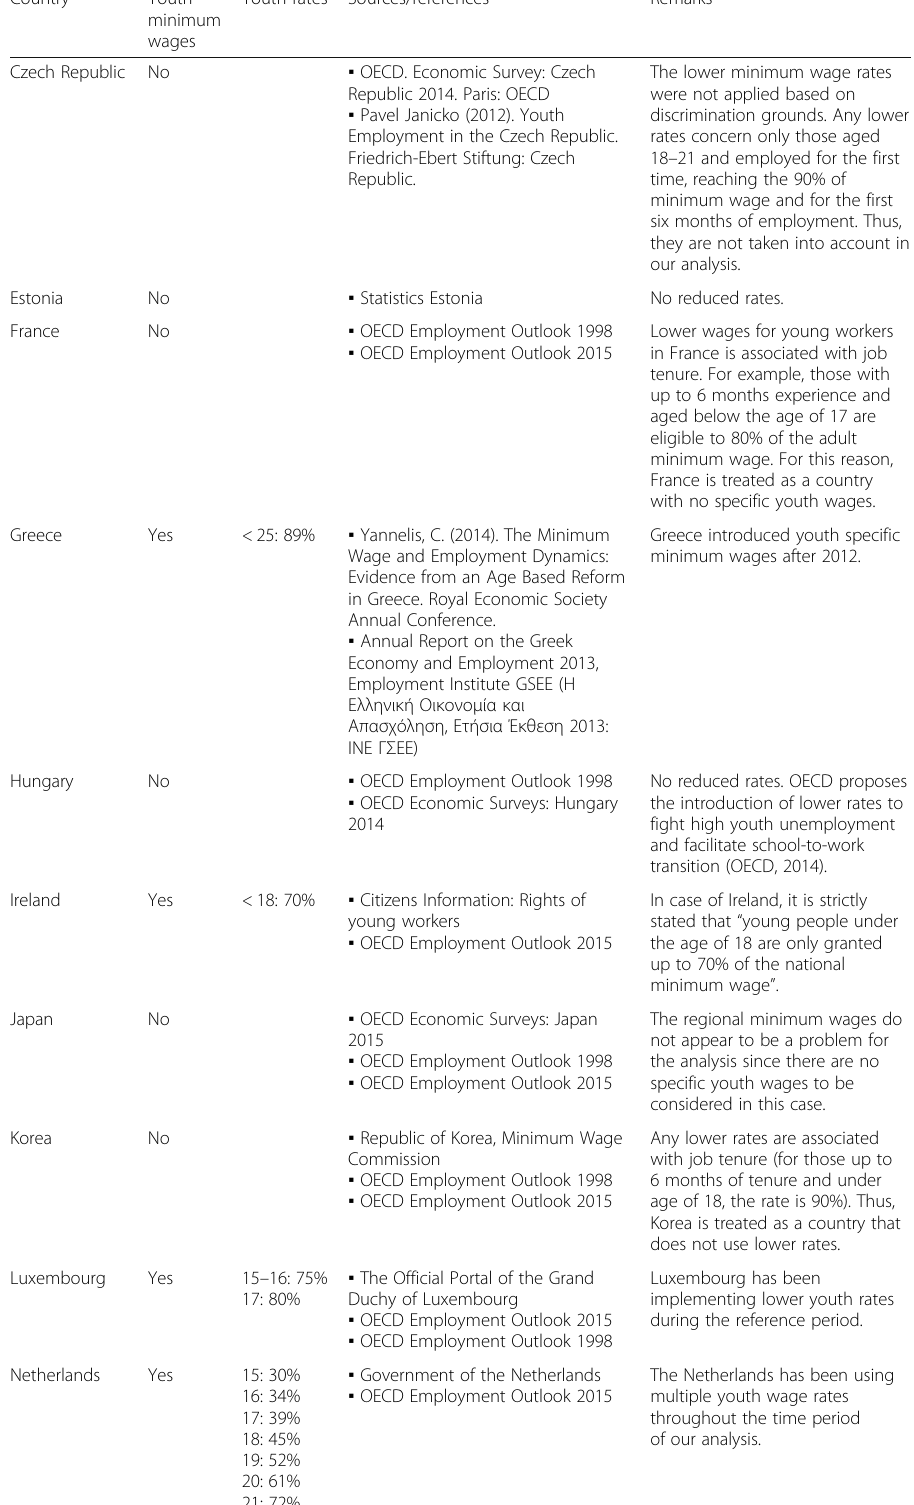
Table 6 Youth minimum wage systems for selected OECD countries